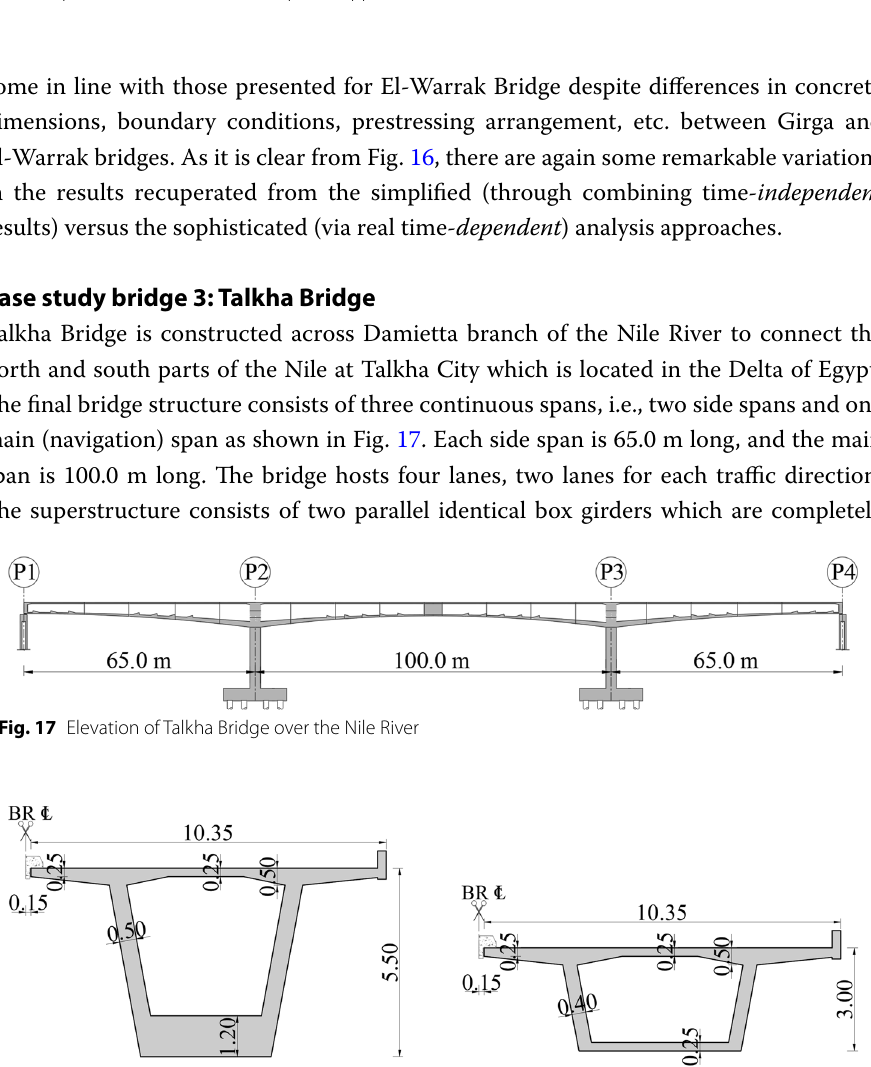
time-dependent moments from simplified approach